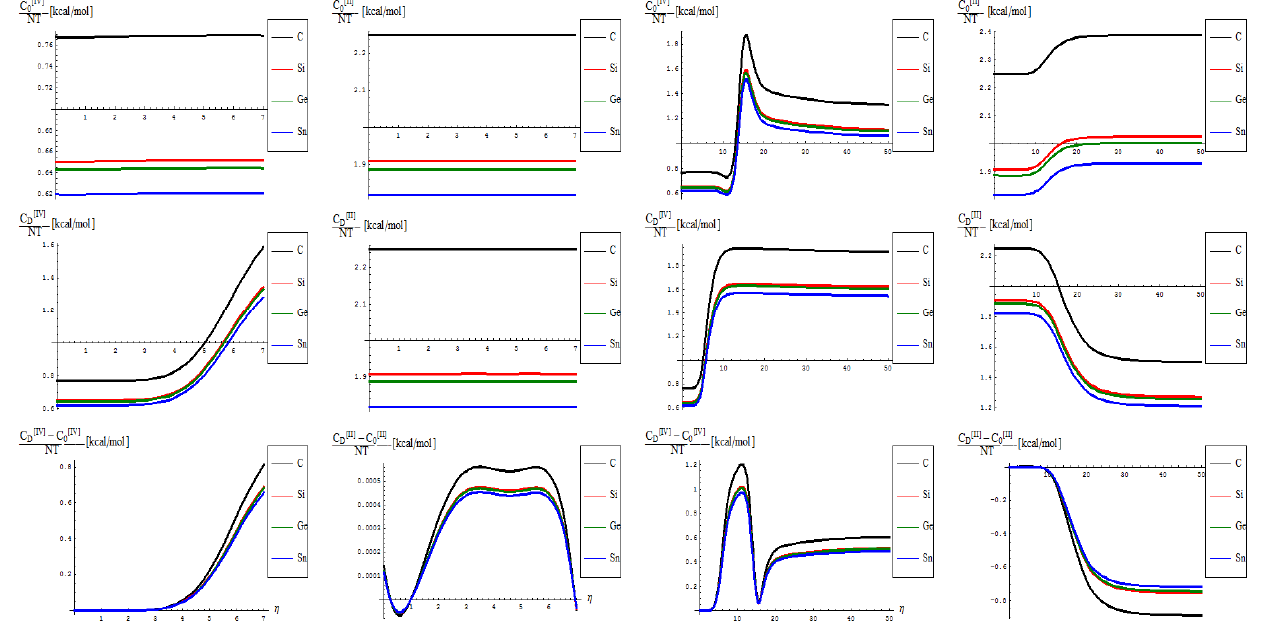
Figure 7. The same type of representations as in Figure 6, here for caloric capacity of Equation (14) and of former formulation of reference [16], in the fourth and second order path integral of bondonic movement,